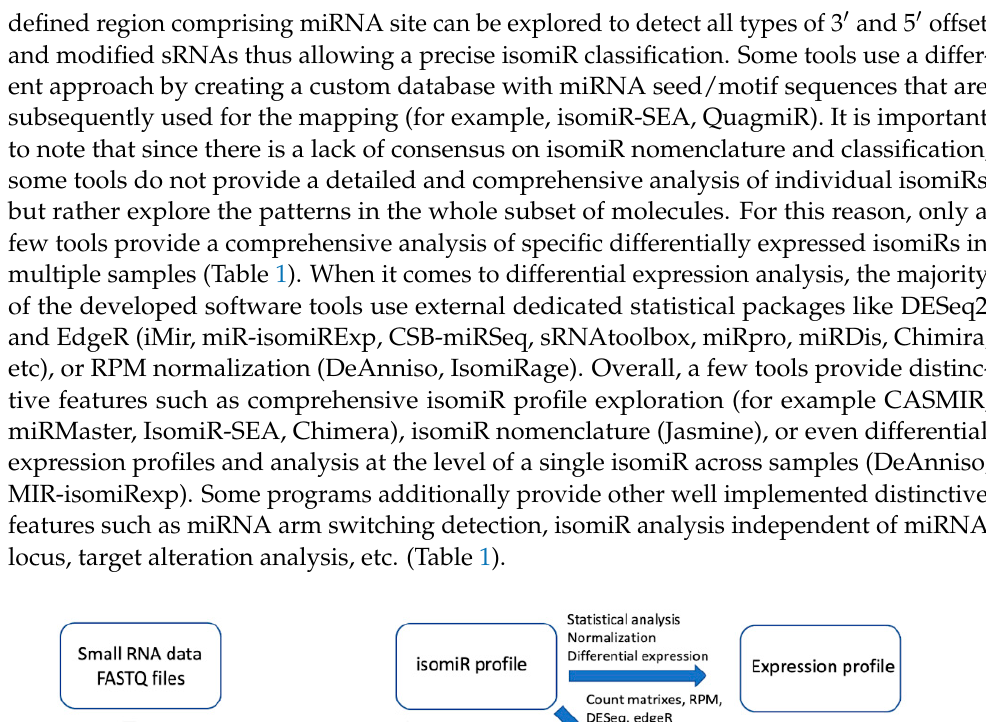
Table 1. List of bioinformatics tools for isomiR identification and analysis in next-generation sequencing (NGS) datasets (The table can be accessed also at https://github.com/Glogobyte/isomiR_tools). Tool Name Type Tool Features